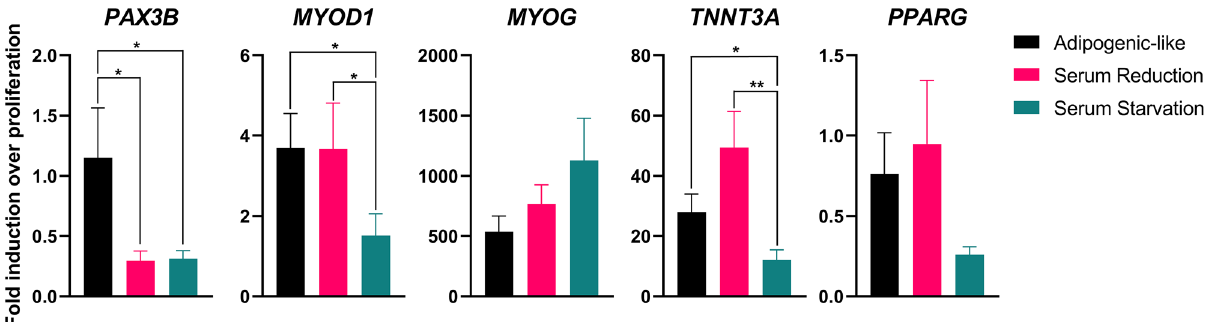
Figure 6. RT-qPCR Gene Expression for PAX3B, MYOD, MYOG, TNNT3A, and PPARG. Fold induction over proliferation is represented as 2 −ΔΔCt . Error bars indicate standard error of the mean, n = 9 (n = 3 experimental, n =